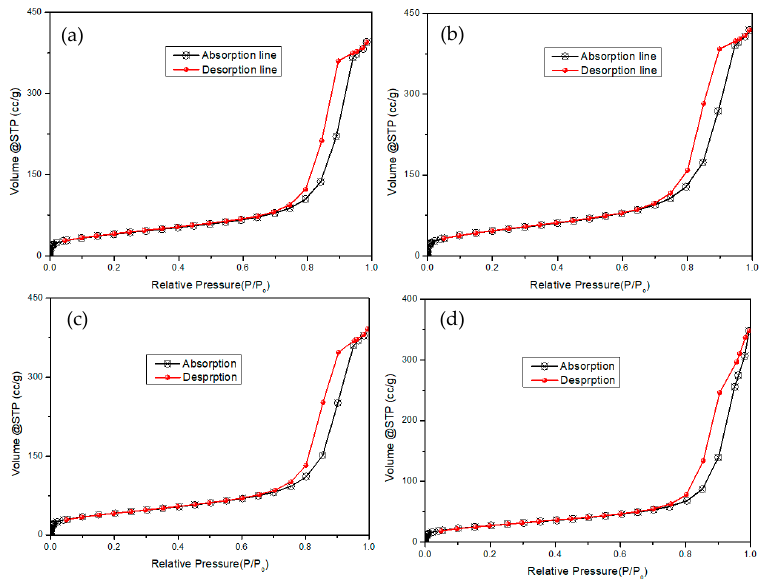
Figure 3. N 2 absorption–desorption isotherms: ( a ) Pd-AlPO-5/SiO 2 , ( b ) Pd-AlPO-8/SiO 2 , ( c ) Pd- AlPO-11/SiO 2 and ( d ) Pd-AlPO-31/SiO 2 .